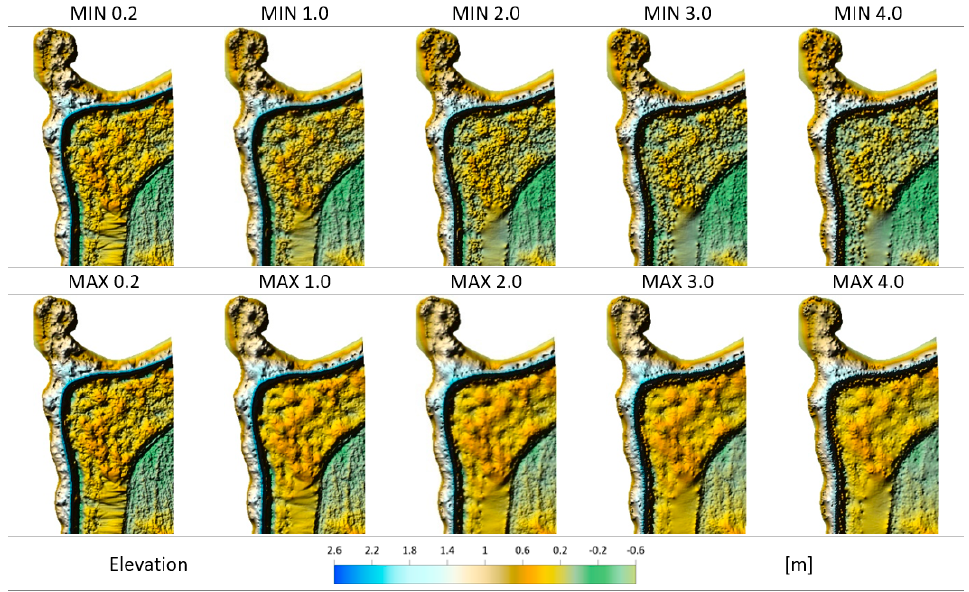
Figure 15. Comparison of DTMs for IDW method.